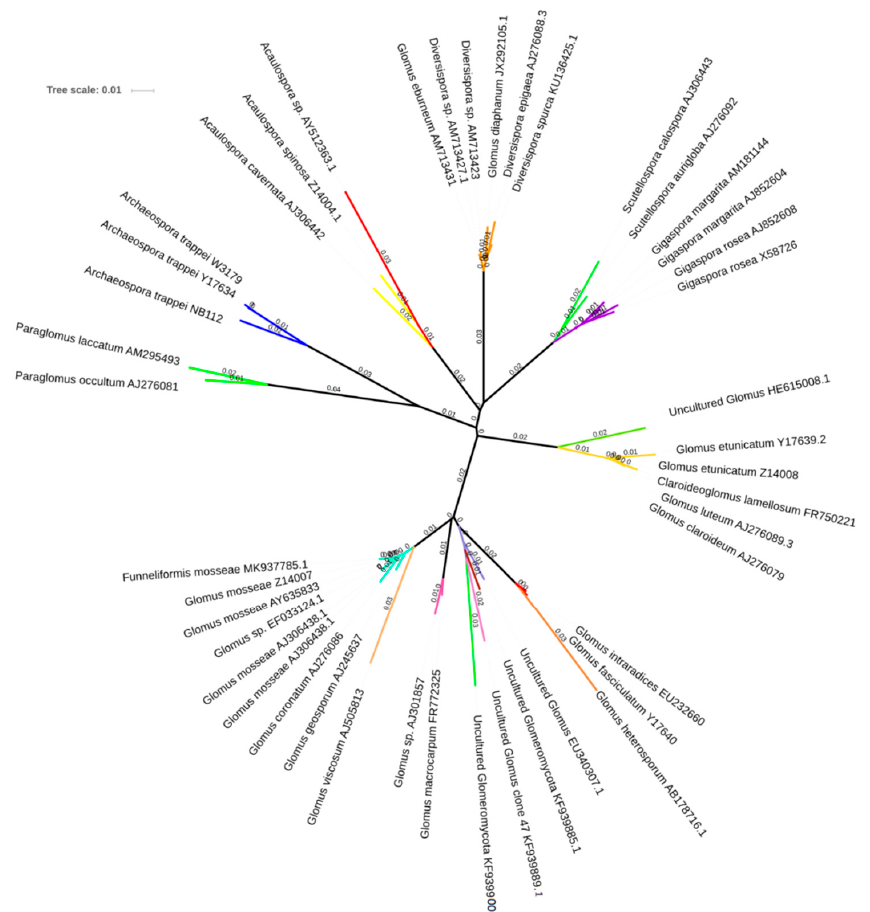
Figure 4. Neighbor-joining consensus phylogram for partial 18S rDNA sequence of arbuscular mycorrhizal fungal spores. Different colors indicate different OTUs at a 97% similarity threshold. Numbers next to the nodes indicate the branch length.